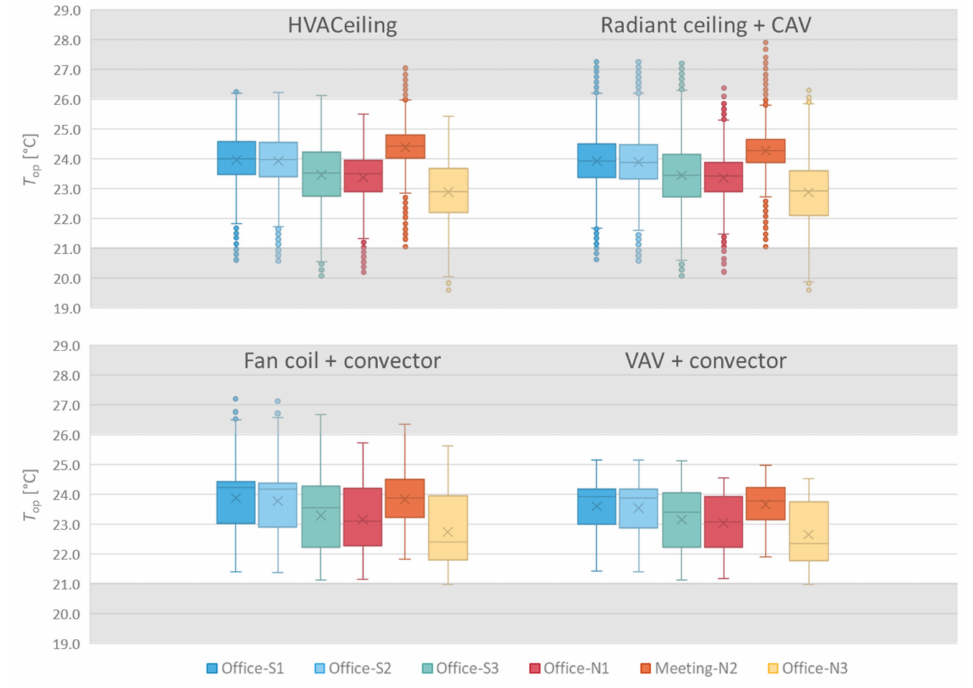
Figure 9. Operative temperatures in all the rooms for the HVACeiling, radiant ceiling, FanCoil, and VAV during office hours 7:00 a.m. to 17:00